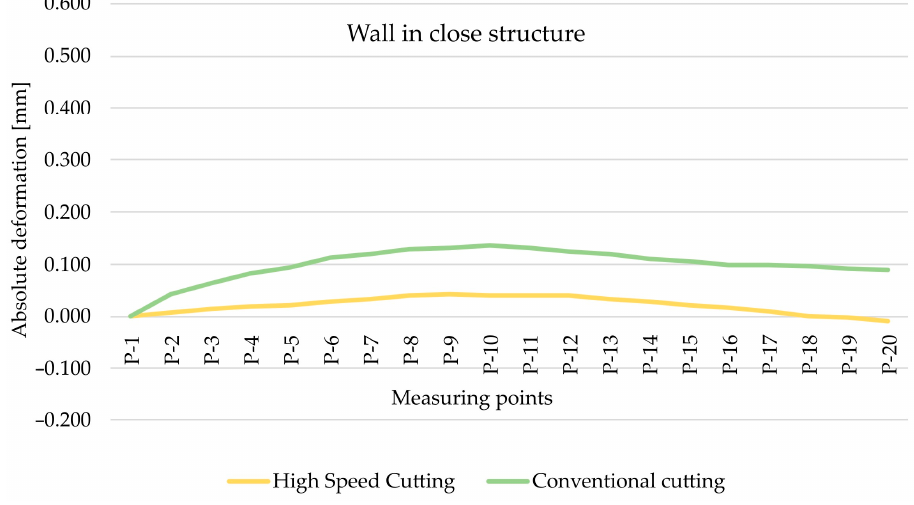
Figure 14. The comparison of absolute deformation for individual measurement points depending on the cutting type for the element with walls arranged in a closed structure made of the EN AW- 6082 T651 aluminium alloy.